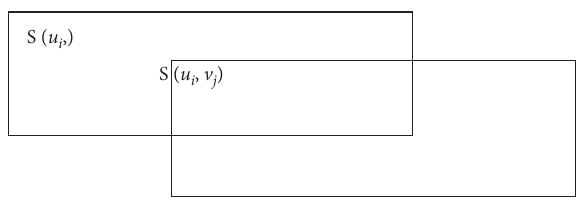
Figure 4: Calculation of the regions’